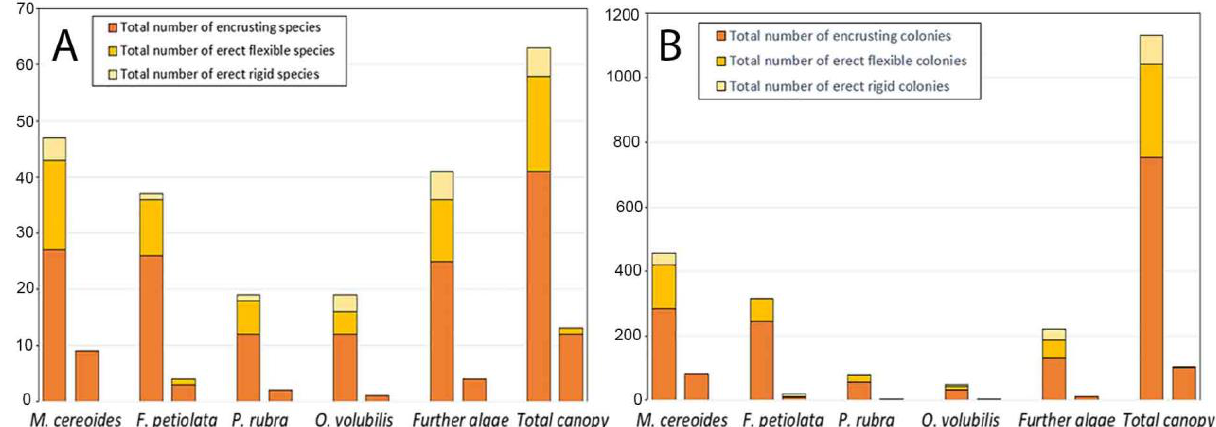
Figure 4. Species richness ( A ) and colony abundance ( B ) of encrusting, erect flexible and erect rigid morphotypes in the bryozoan epibiont living (left column) and dead (right column) assemblages found on the bryozoan Margaretta cereoides and the main algae of the canopy on the build-up E collected offshore Marzamemi (Ionian Sea).